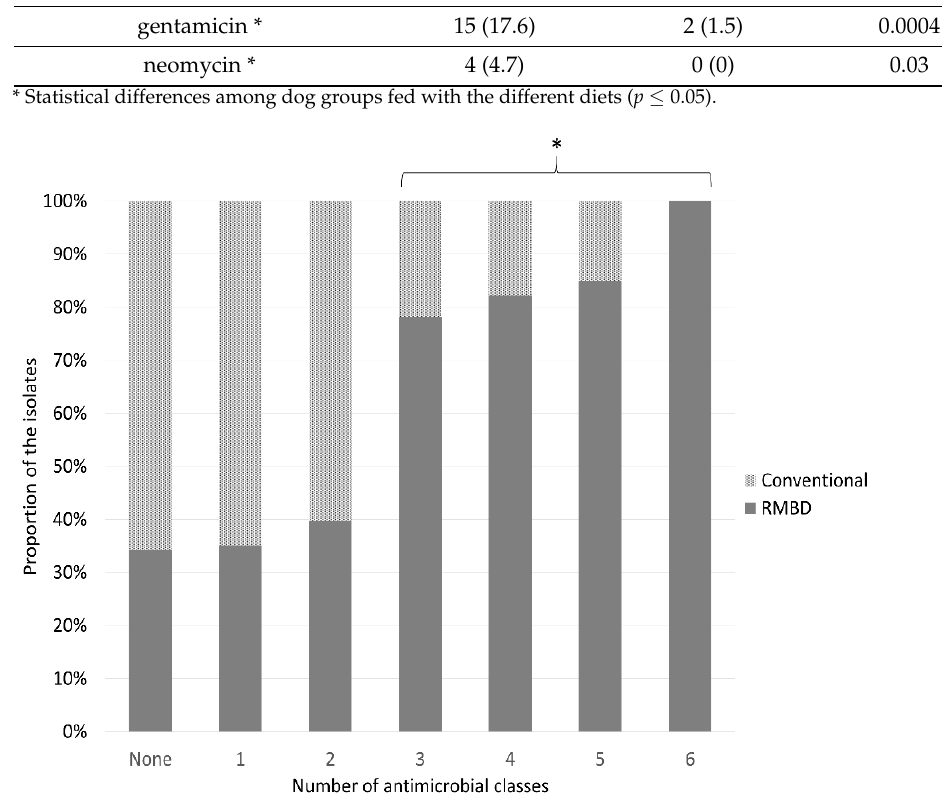
Figure 1. Percentages (%) of E. coli isolates from dogs fed raw meat-based diets (RMBDs) ( n = 85) or conventional dry feed ( n = 127) that are resistant to different numbers of antimicrobial classes. (*) Dogs fed an RMBD were more likely to shed E. coli strains resistant to three or more antimicrobials (95% CI: 3.6 – 14.7; p = 0.0004).